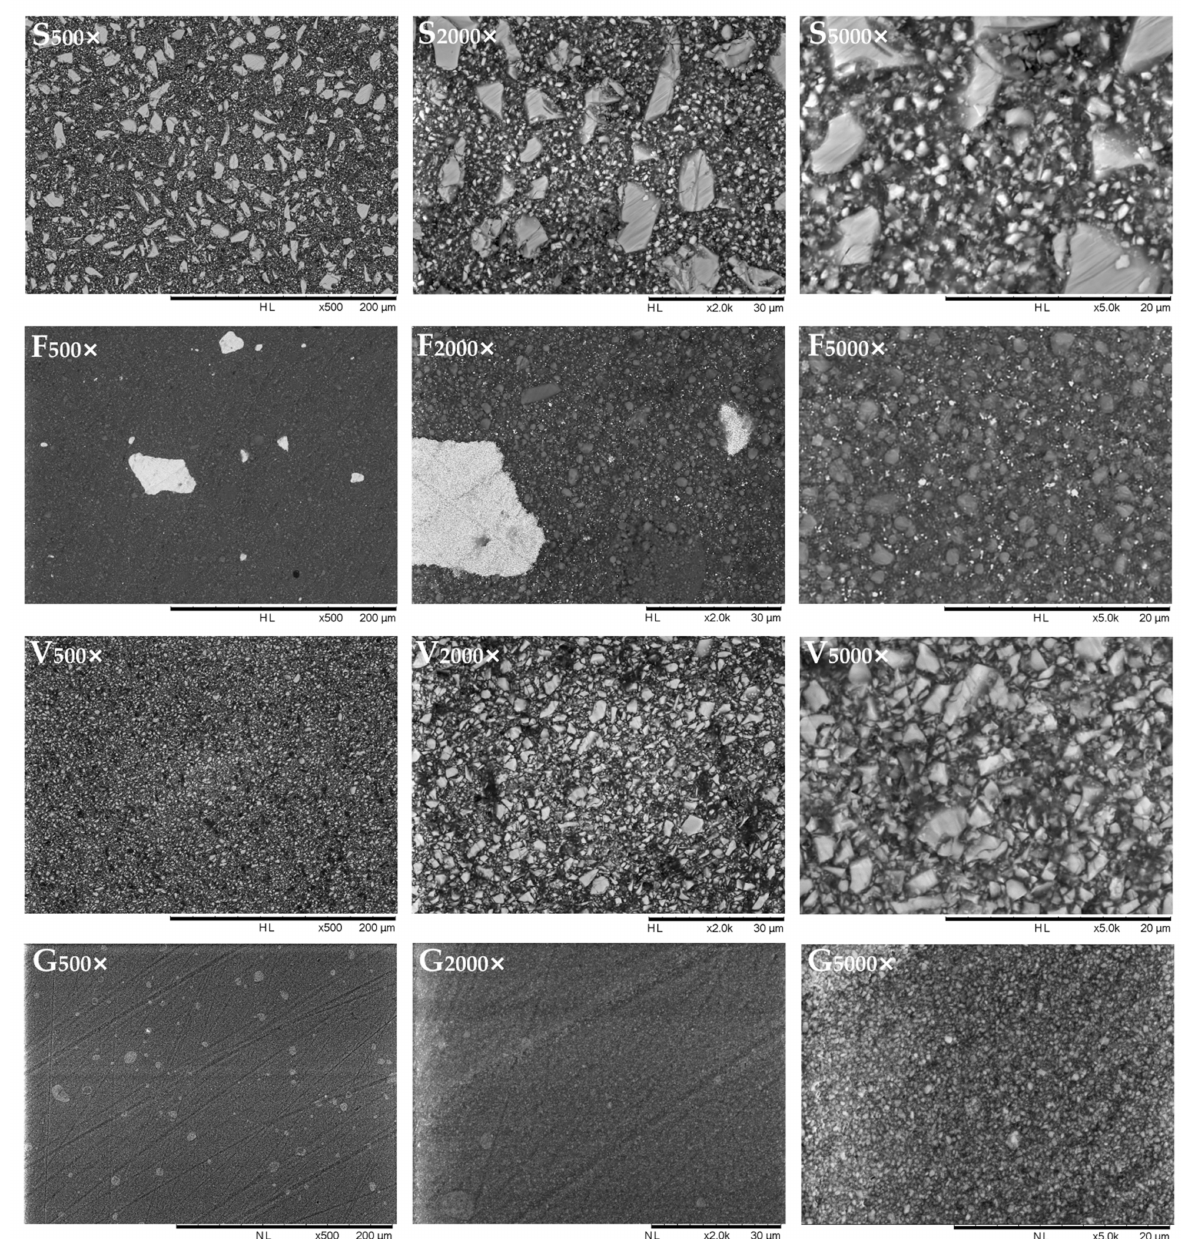
Figure 1. Representative SEM micrographs (500 × , 2000 × and 5000 × ) of the tested polymeric materials’ surfaces acquired in backscattered mode. Under such electron detection conditions, elements with relatively high atomic number (Sr, Zr, and especially Ba and Yb) reflect electrons more than elements with lower atomic number (C). In this way, they are depicted as white-ish while the organic resin matrix is black. Elements such as F, Al, and Si provide intermediate gray-scale values. This observation allows to better highlight filler size and shape and provides a preliminary qualitative insight on fillers’